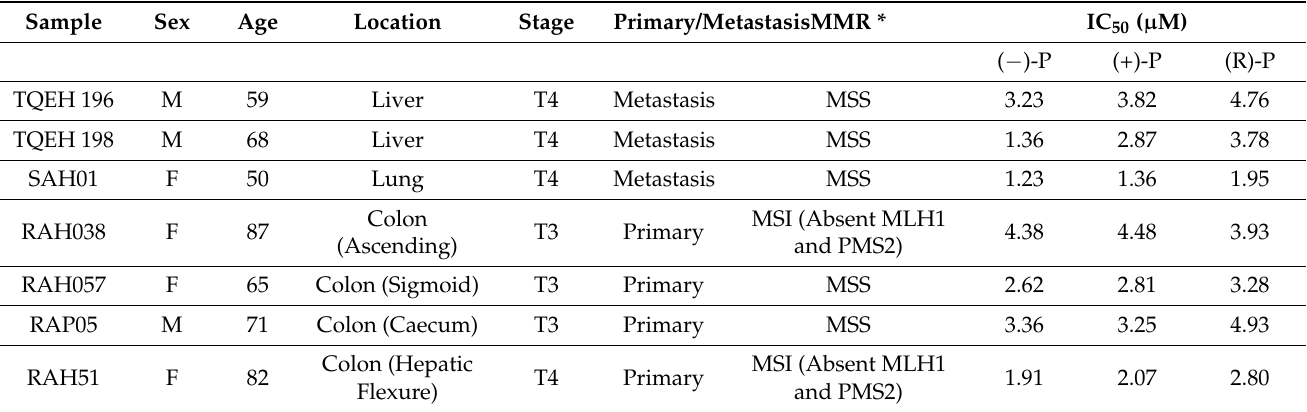
Table 3. CRC patient-derived organoids—patient characteristics and IC 50 of response to ( − )-P, (+)-P and